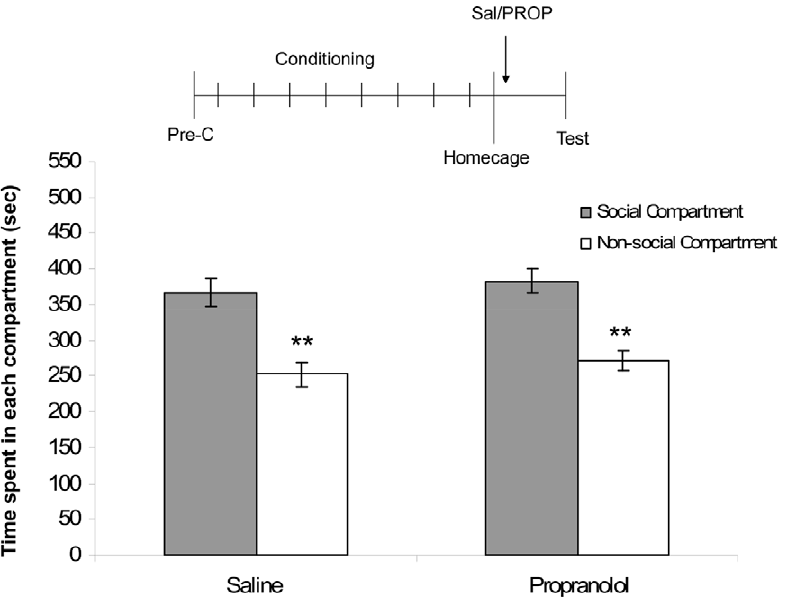
Figure 3. Effects of PROP on social play-induced CPP in the absence of memory-retrieval. The experimental protocol is depicted above the graph (Pre-C: pre-conditioning test). Data represent the mean time (sec 6 SEM) spent in the social compartment (grey bars) and the non-social compartment (white bars) during a 15 min test session. Saline-treated animals (2 ml/kg, i.p. , n=16), PROP-treated animals (10 mg/kg, i.p. , n=16). Post-hoc Student’s paired t-tests for difference in time spent in the social- and non-social compartment **p , 0.01.